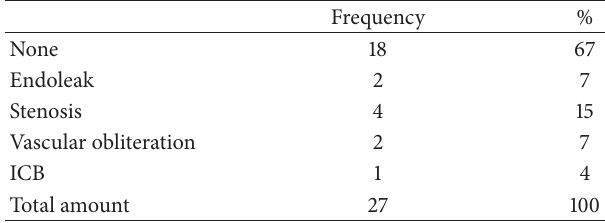
Table 4: Complications during